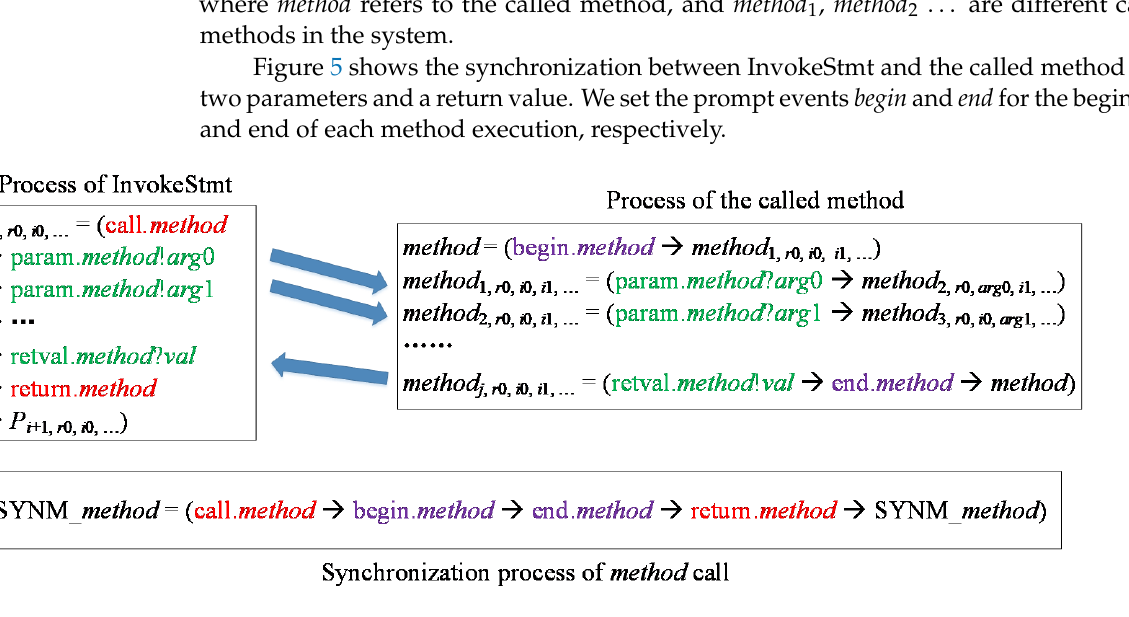
Figure 5. Synchronization between InvokeStmt and the called method.